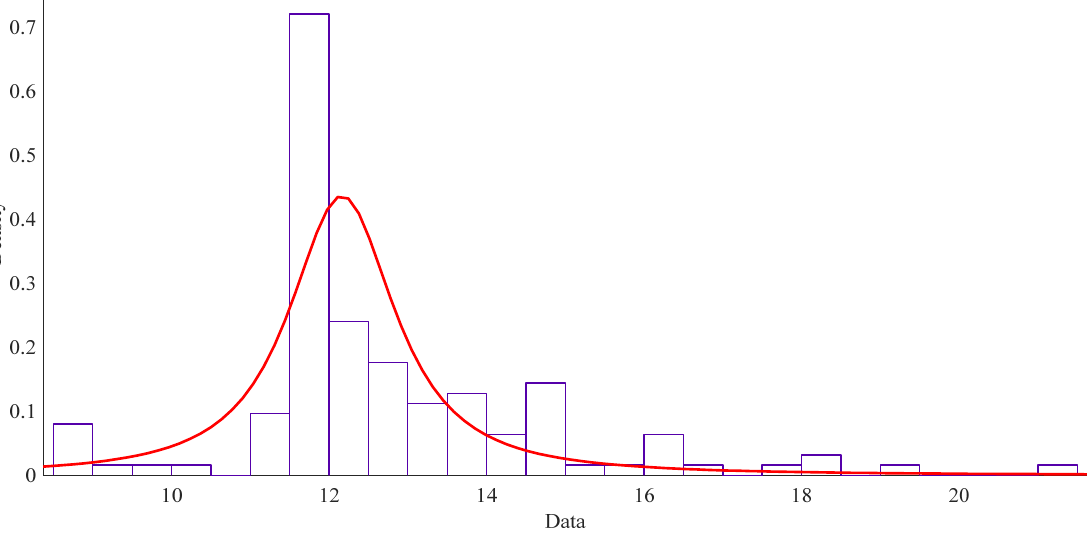
Figure 12. Histogram of the k stiffness data and t location-scale distribution. The derived pdf may of course be used for assigning probabilities of occurrence to different values of k . For example, the corresponding probability that k receives values smaller than 8.0 is equal to